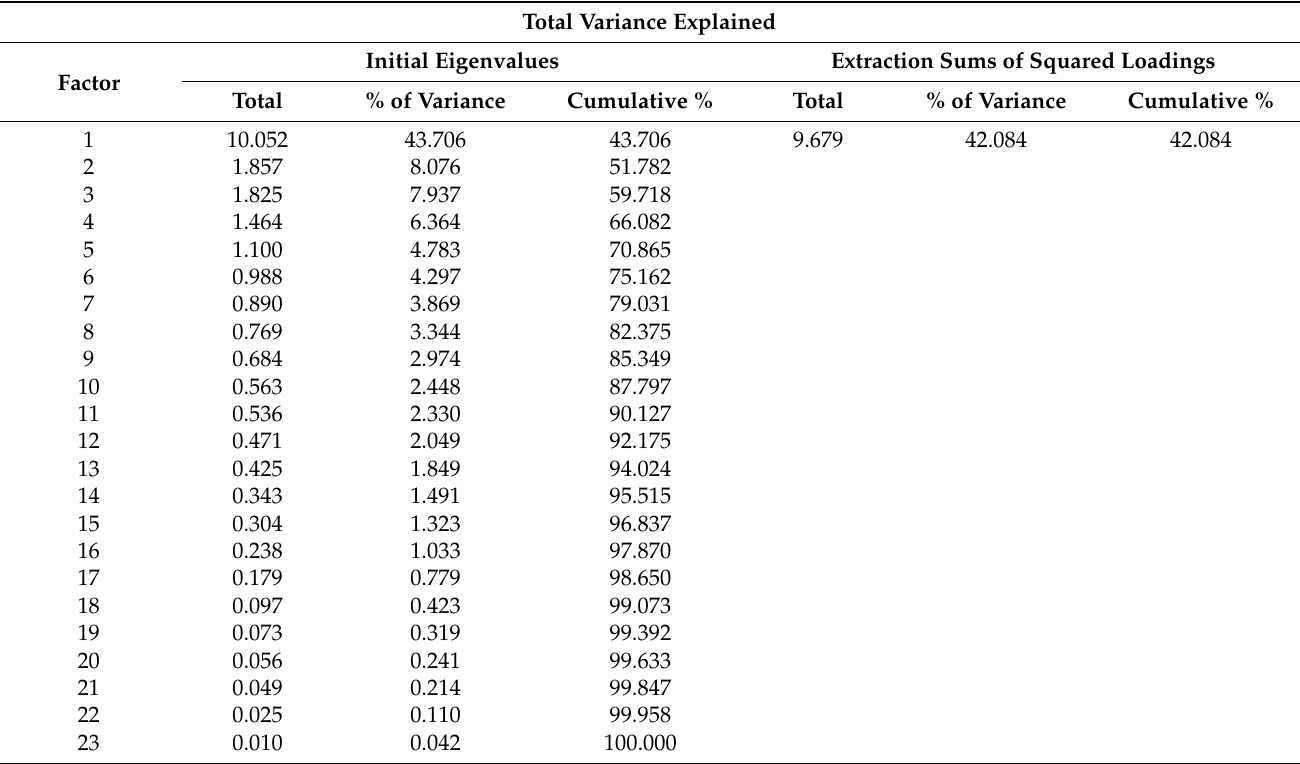
Table A4. Harman’s Single Factor of Common Source Bias.